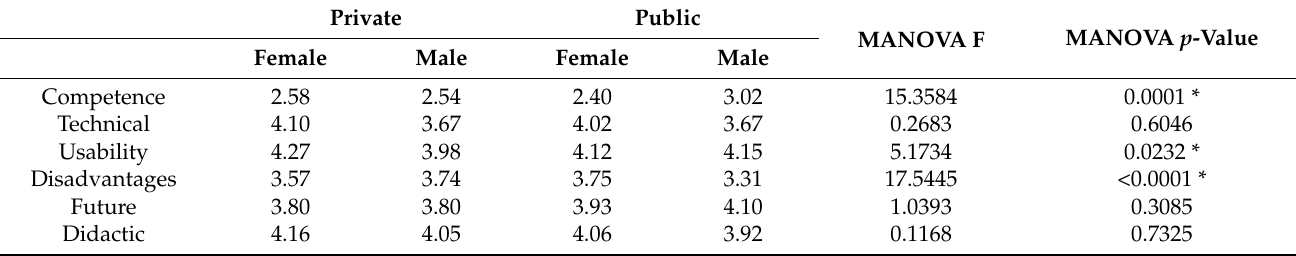
Table 5. Mean responses (out of 5) and the statistics of the MANOVA test for the comparison of means when participants are differentiated by their university tenure and gender (270 participants).